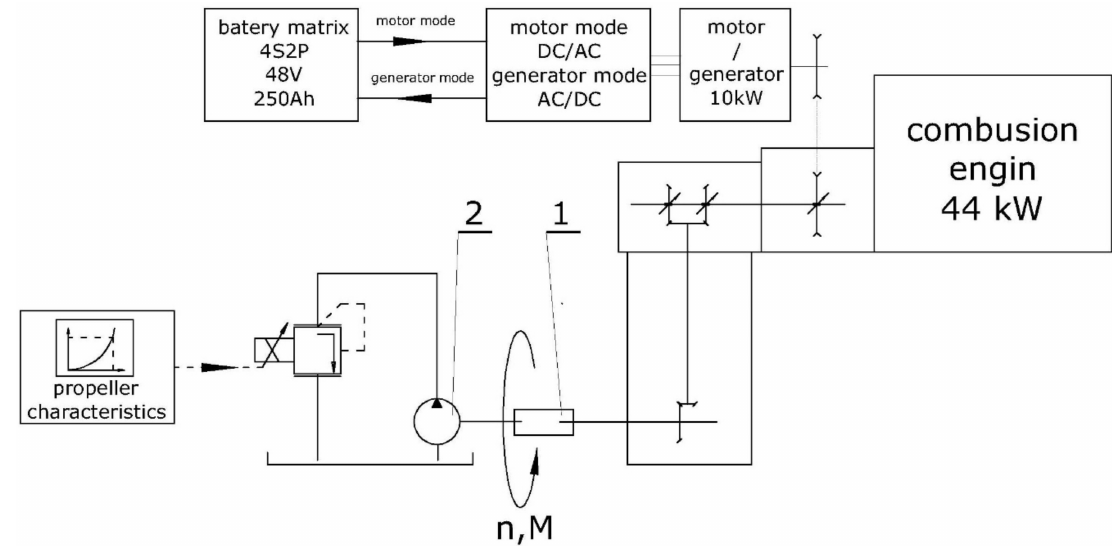
Figure 8. Test rig schematic; 1—torque meter on the main shaft, hydraulic pump and hydraulic system for applying load, 2—hydraulic pump—load system.